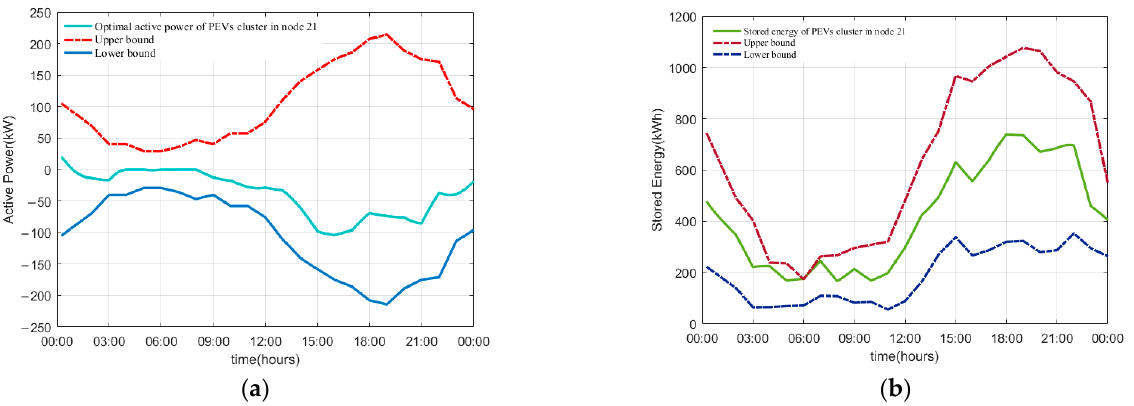
Figure 15. ( a ) Active power. ( b ) Stored energy of the cluster of PEVs in node 21 with their limits.